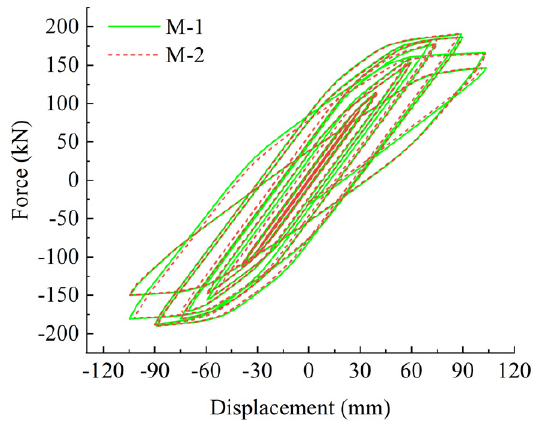
Figure 21. Hysteresis curves of M-1 and M-2.